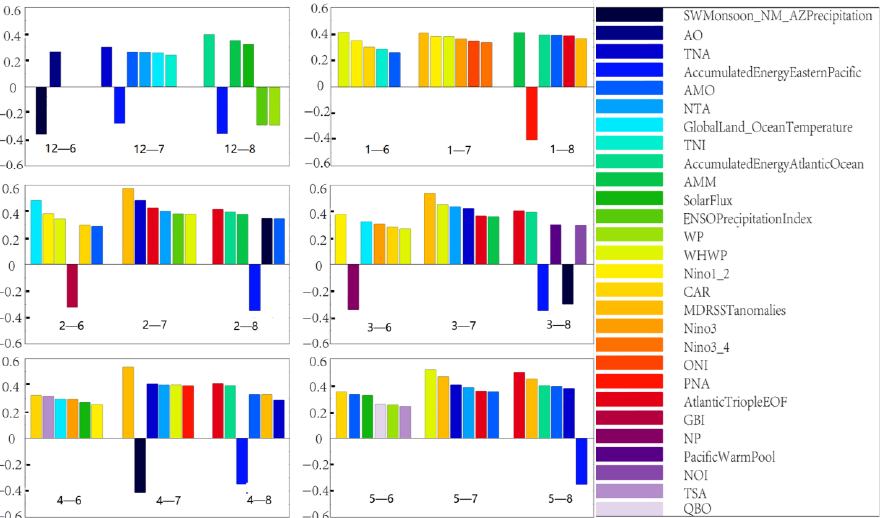
Figure 3. Correlation coefficient between a factor of an antecedent month in the previous win- ter/spring and the precipitation of a month in summer (e.g., “12-6” means the correlation between a December factor and the following June precipitation).